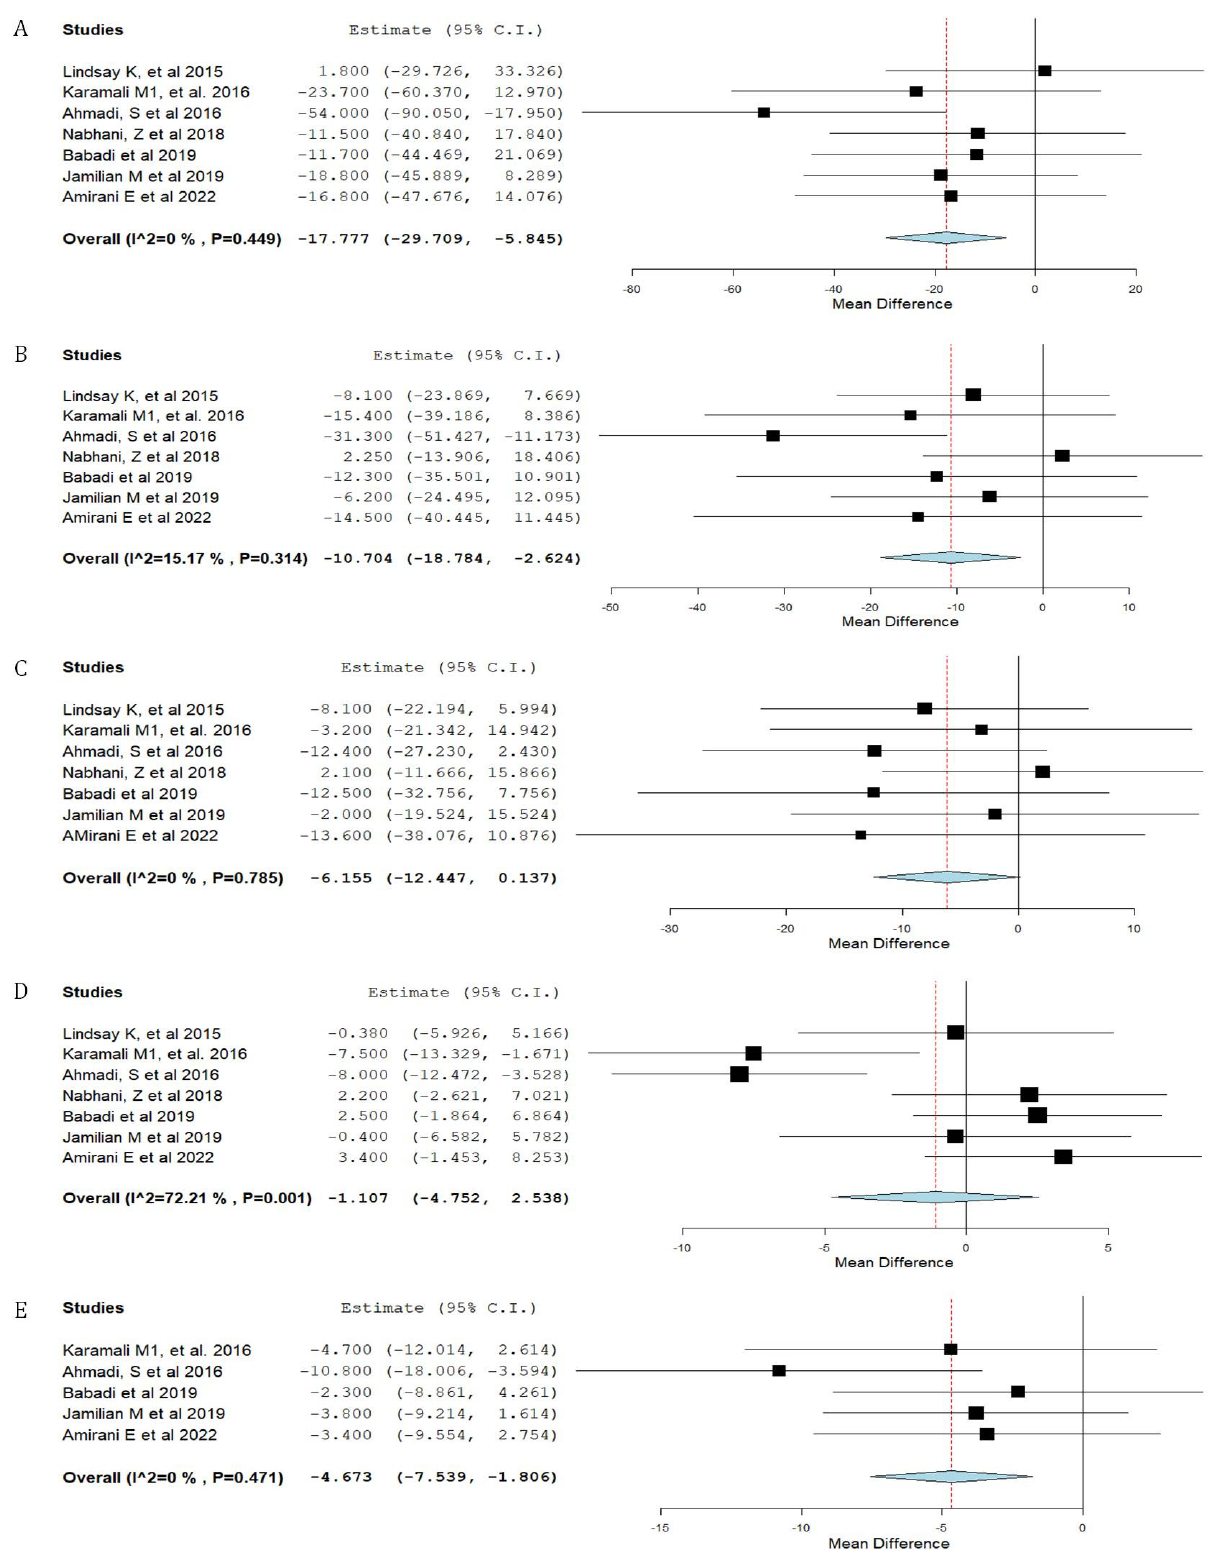
Figure 4. Forest plot of probiotic treatment versus placebo and lipid profile. ( A ) Triglycerides (mg/dL) [12,24–26,28,31,35], ( B ) total cholesterol (mg/dL) [12,24–26,28,31,35], ( C ) low-density lipoproteins (mg/dL) [12,24–26,28,31,35], ( D ) high-density lipoproteins (mg/dL) [12,24–26,28,31,35], and ( E ) very-low-density lipoproteins (mg/dL). C.I.: confidence interval [12,25,28,31,35].